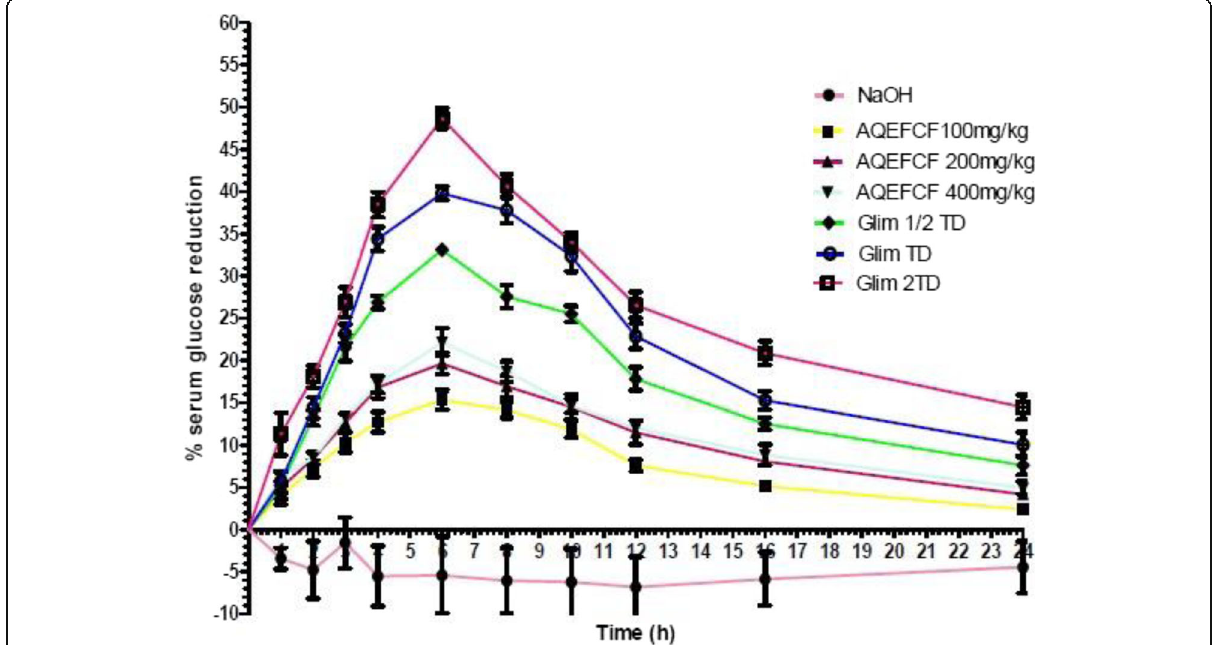
Fig. 2 Effect of single dose of C.frutescens and glimepiride on serum glucose level in diabetic rats